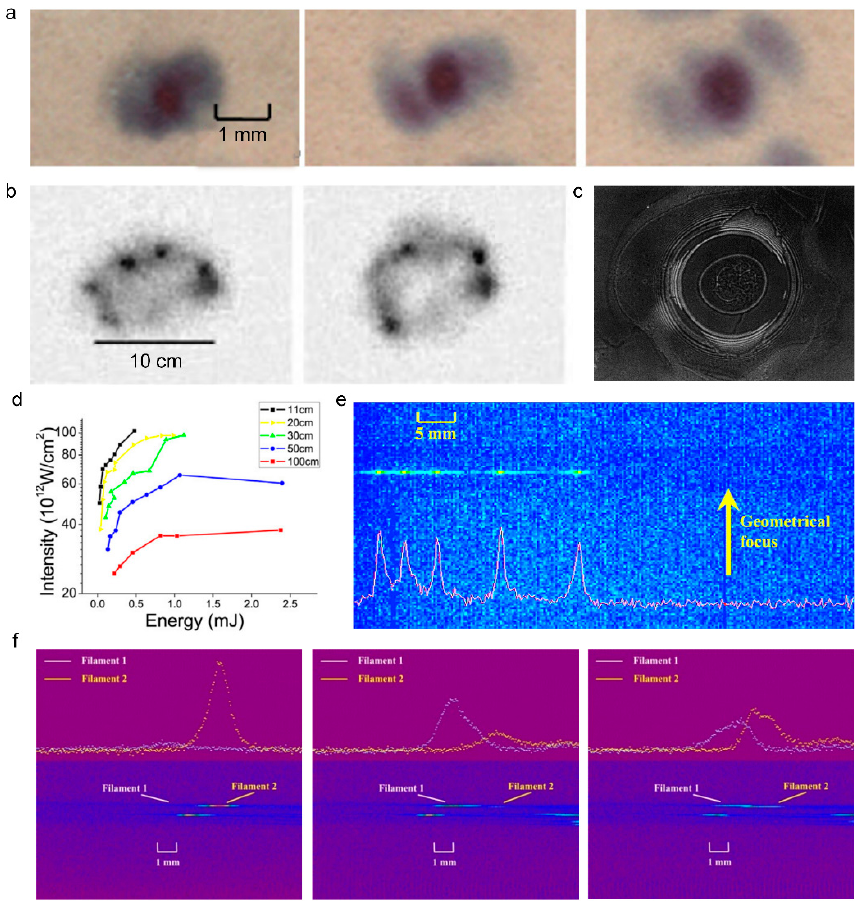
Figure 5. Sensing of laser intensity in filament. ( a – c ) Transverse laser intensity profile by exposure of ( a ) burn paper [121], ( b ) photographic plates [120], and ( c ) ablation of silica glass plates [122]. ( d – f ) Measurement of laser intensity by fluorescence of filament: ( d ) laser peak intensity as a function of input laser energy [123]; experimental observation of ( e ) multiple self-focusing [124] and ( f ) multifilament competition [10].